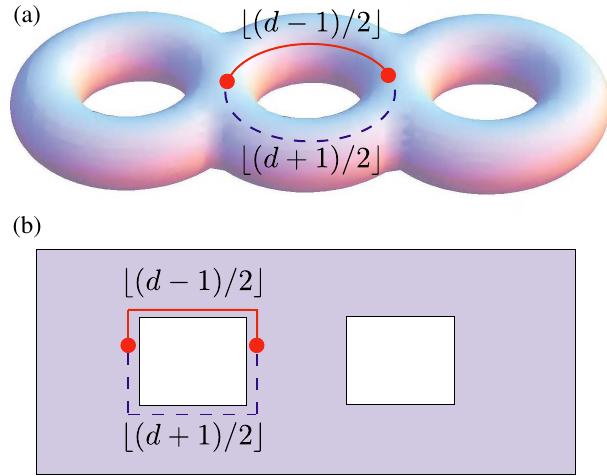
FIG. 15. Minimum-weight paths on (a) a genus- g surface and (b) a surface with hole defects. The red dots indicate the syndromes. The red lines correspond to the actual data qubit error string and the correct minimum-weight path. The blue dashed lines indicate the distorted path which induces a logical